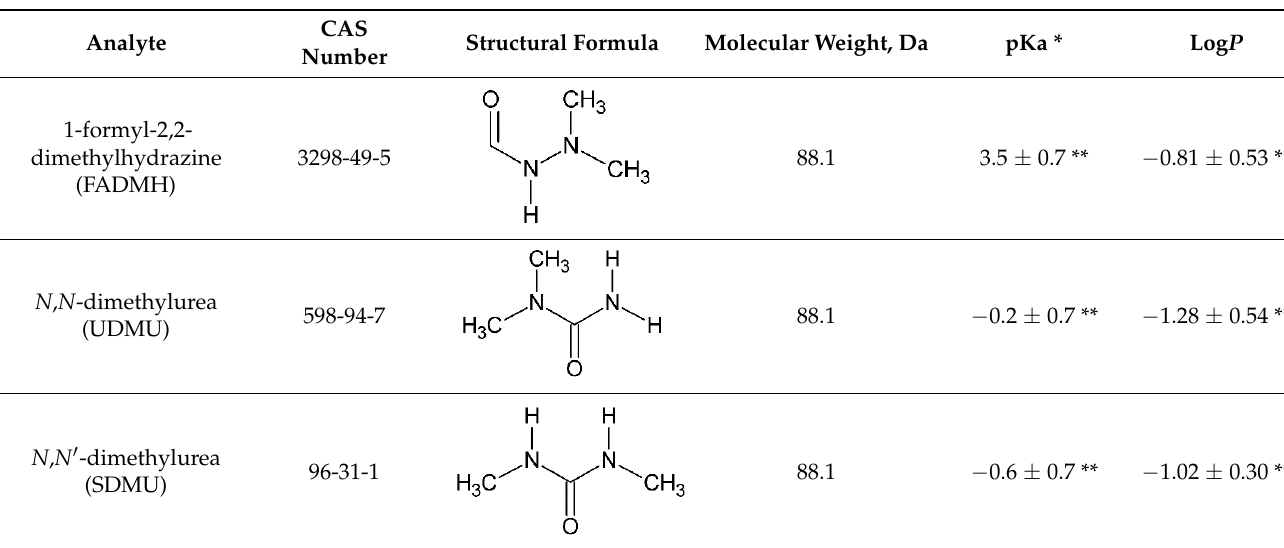
Table 1. List of analytes and their physicochemical properties.